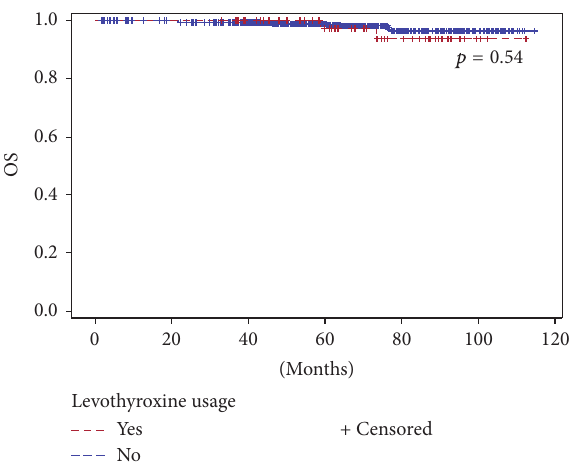
Figure 3: Overall survival according to levothyroxine